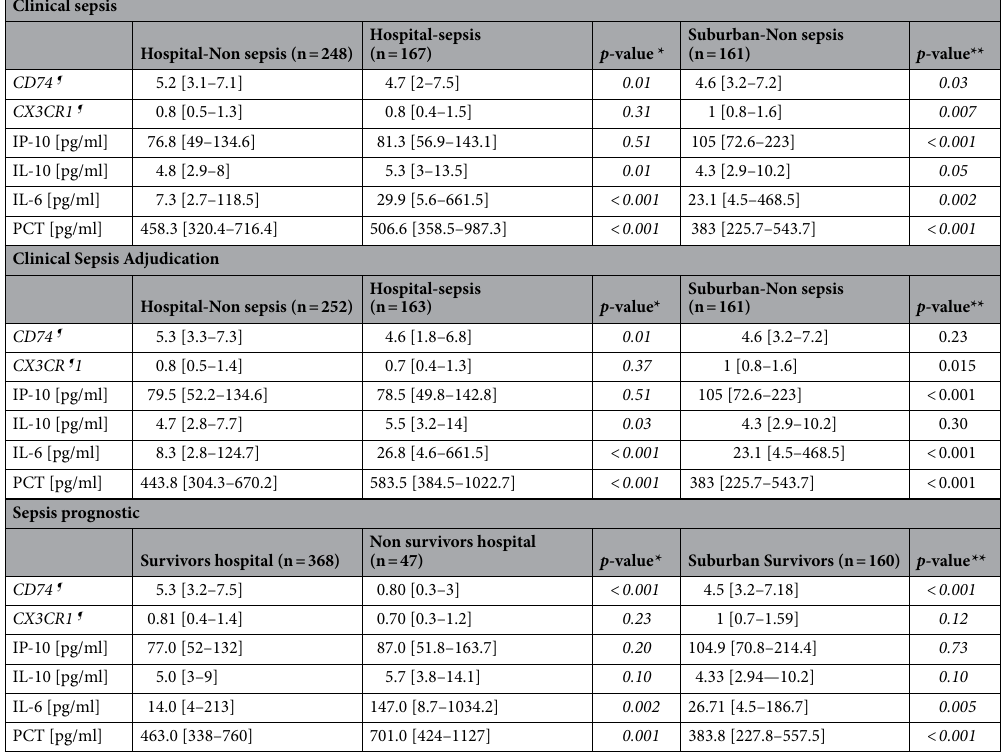
Table 3. Cord blood biomarkers level in neonatal sepsis. Biomarkers are expressed as median and inter- quartile range (IQR: Q1–Q3). ¶ CD74 and CX3CR1 are expressed as relative expression to HPRT1. * Student’s t-test (or the Mann–Whitney t-test when distribution was not normal or Welch test when homoscedasticity was rejected) were performed to compare two hospital arms groups. ** Anova test was performed to compare biomarkers levels between the three groups. p value was considered significant ≤ 0.05. CD74 , HLA class II histocompatibility antigen gamma chain; CX3CR1; CX3C chemokine receptor 1; IL , Interleukin; PCT,